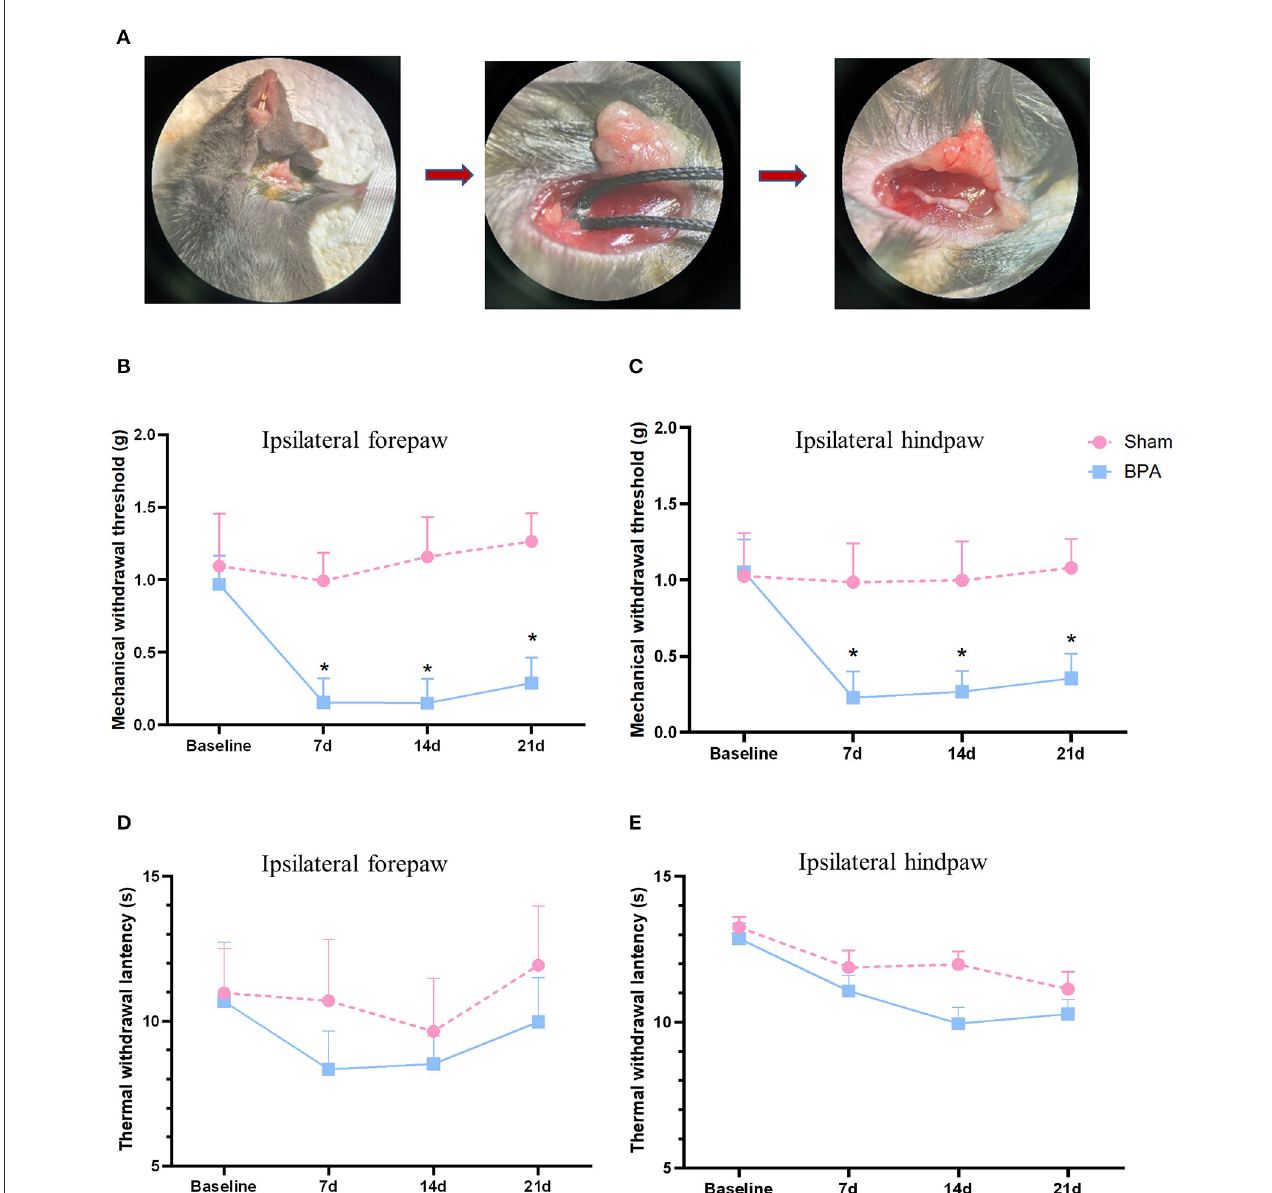
FIGURE1 BPA modeling and pain behavior detection over time. (A) Schematic diagram of BPA operation: from brachial plexus dissociate the C7 nerve separation to nerve avulsion. (B) PMWT results of the operative limb 1 day before and 7, 14, and 21 days after modeling. (C) PMWT results of the ipsilateral hindlimb of sham and BPA mice. (D) No significant difference of TWL in the operative limb between sham and BPA mice at 1 day before and 7, 14, and 21 days after modeling. (E) TWL results of the ipsilateral hindlimb of the two group at each time point. N = 10 per group. * P < 0.05 vs. sham at the same time point. Unpaired T -test was used for data analysis. BPA, brachial plexus avulsion; PMWT, paw mechanical withdrawal threshold; TWL, thermal withdrawal